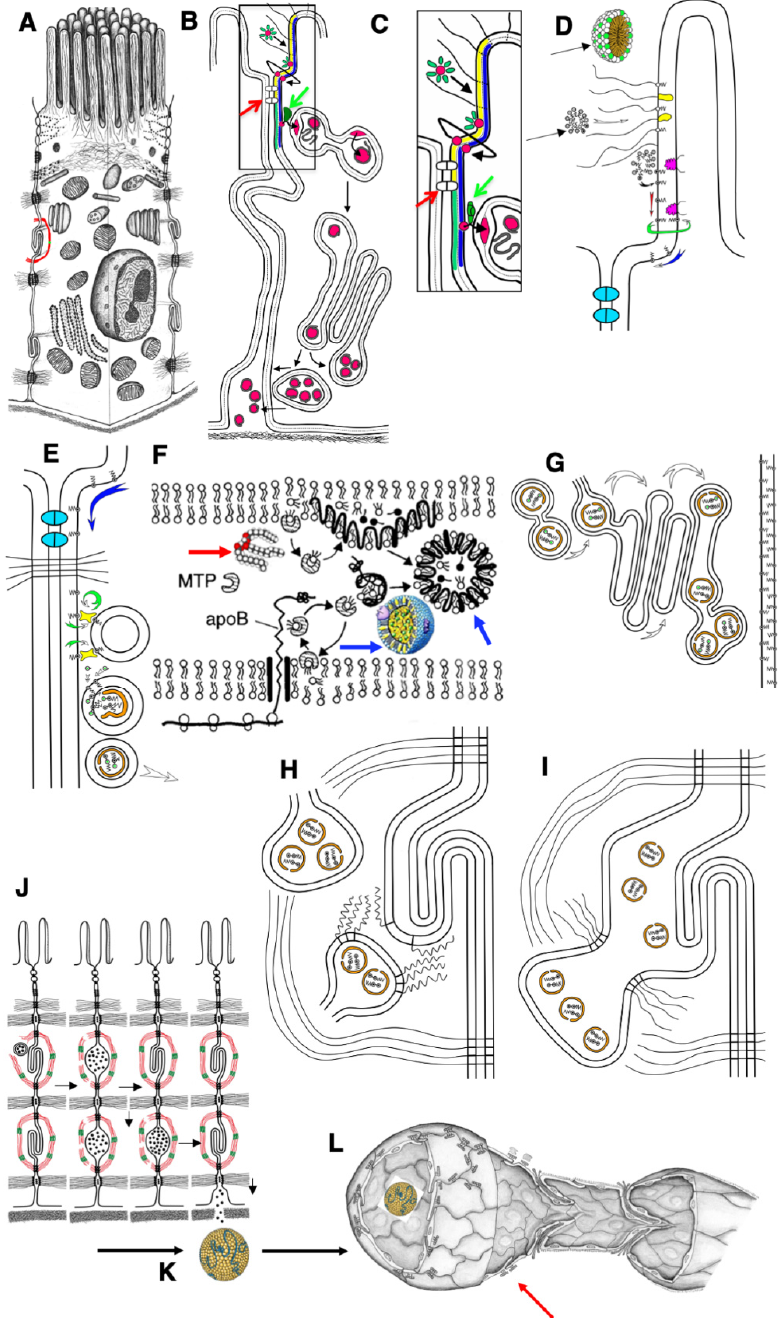
Figure 9. Schemes of the mechanisms of lipid transcytosis across enterocytes and their uptake by lymphatic capillary in adult rats (adapted from [4]). ( A ) Enterocyte. ( B ) The gut micelle (red ring surrounded with green ovals) is composed of free fatty acids (FFAs), cholesterol and bile acids (green ovals). The micelle passes through glycocalyx (black lines) and contacts with the external leaflet of the apical plasma membrane (APM; yellow layer). Then, FFAs and cholesterol are sub- jected to flip-flop (the bent line shows this path of red ring) and appear in the cytosolic leaflet of the APM (blue layer). ( C,D ) Higher magnification of the pathways shown in ( B ). ( D ) The micelles (black arrows) pass through glycocalyx (white arrow). Membrane proteins containing long polysaccharide chains of glycocalyx are yellow. Caveolin is magenta. FFAs (dots, black center) are inserted into the